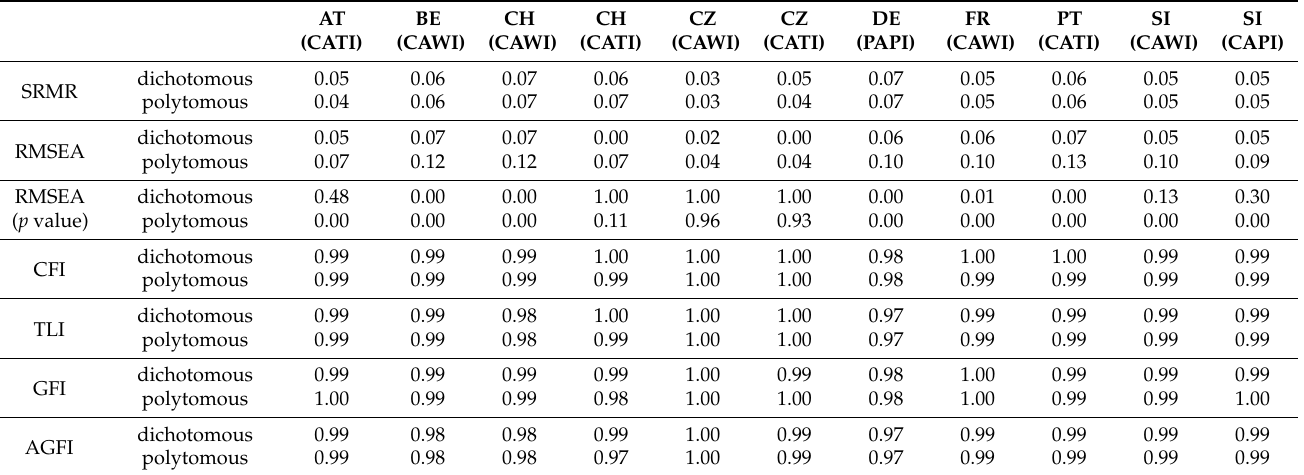
Table 4. Goodness-of-fit indices for single-factor CFA of the HLS 19 -NAV based on dichotomous and polytomous data (based on HLS 19 Consortium [17] (p.